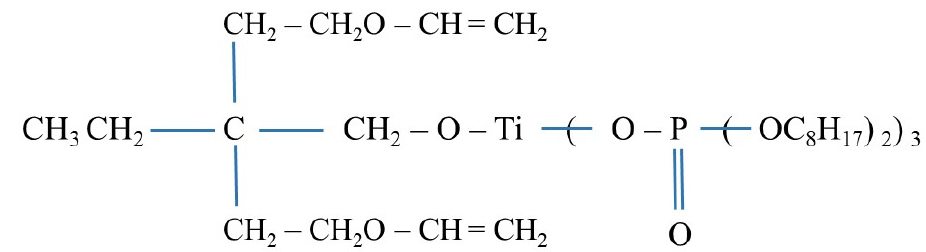
Figure 1. Chemical structure of Ken-React ® LICA ® 12 (20% active portion of CAPS ® L ® 12/L). Appl. Sci. 2018, 8, x FOR PEER REVIEW Figure 1 . Chemical structure of Ken ‐ React ® LICA ® 12 (20% active portion of CAPS ® L ® 12/L).